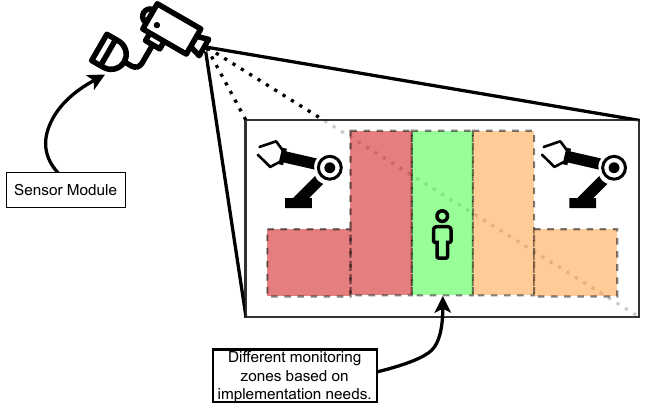
Figure 4. Example of factory floor zoning based on the definition of zones surrounding operating collaborative robotic arms, and safe zones where people can occupy in their daily